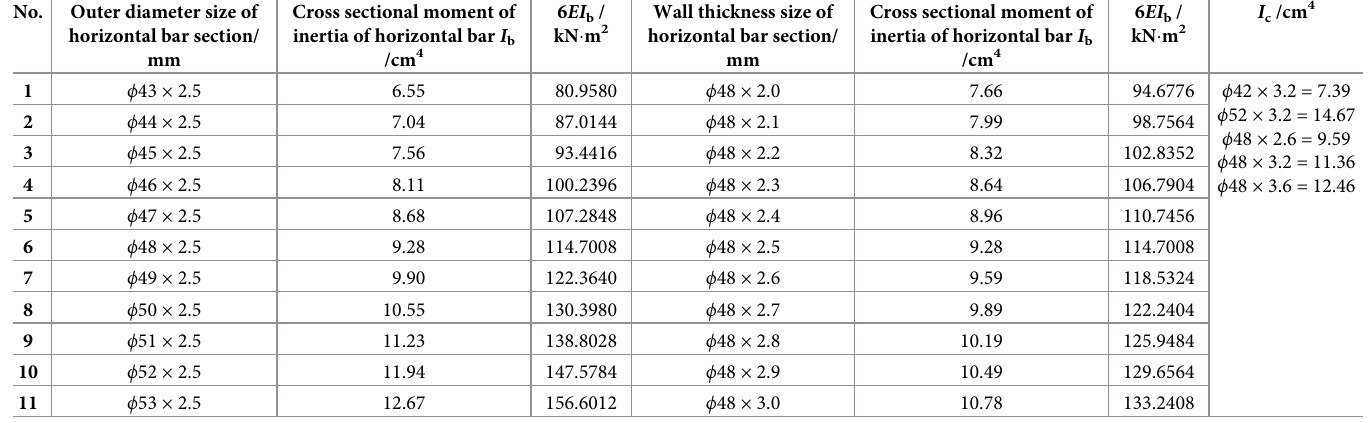
Table 8. Parameters related to section size of horizontal bar and the effective length correction